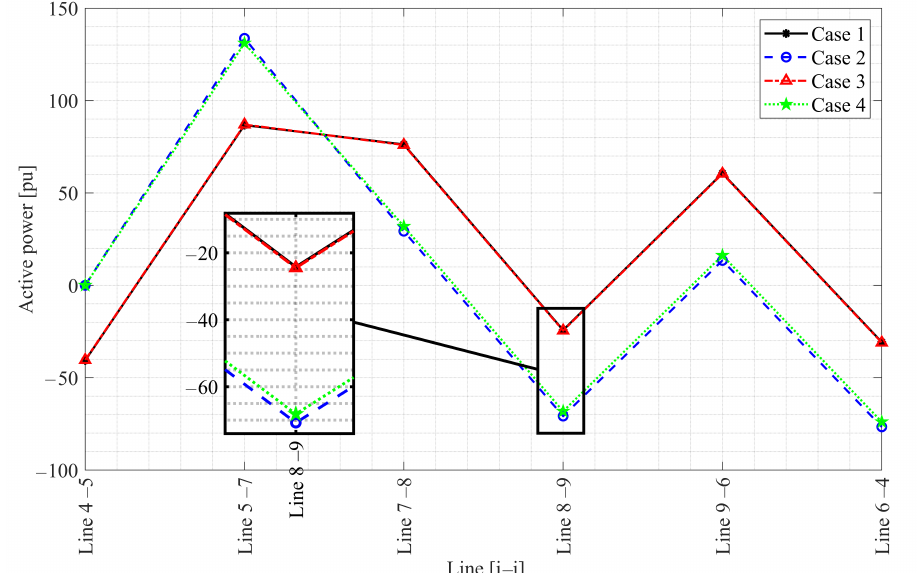
Figure 3. Active power flow in the 9-bus bar IEEE